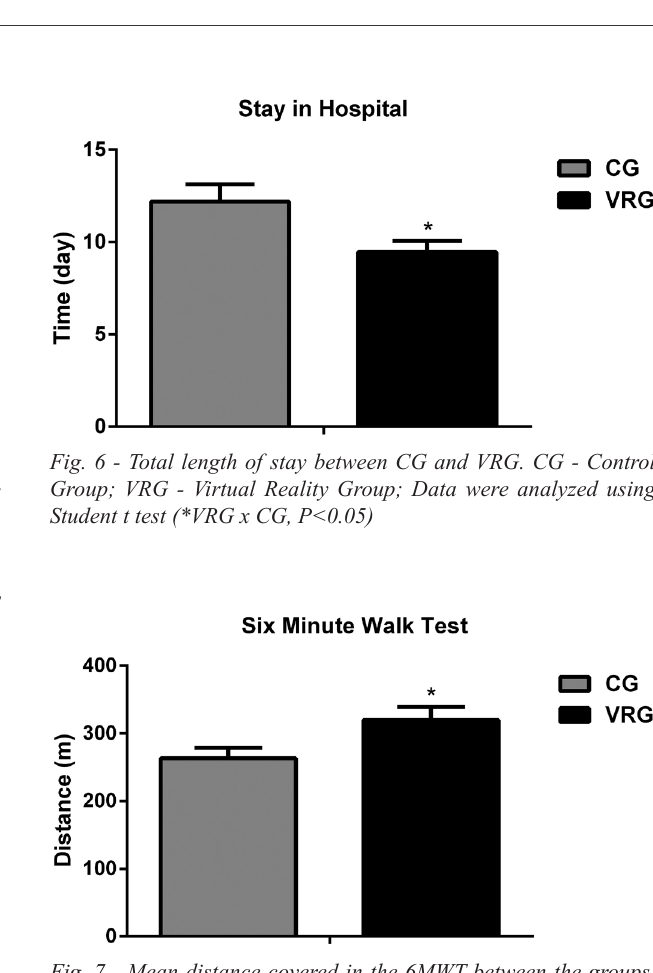
Fig. 7 - Mean distance covered in the 6MWT between the groups. CG - Control Group; VRG - Virtual Reality Group; 6MWT – Six minute walk test. Data were analyzed using Student t test (*VRG x CG,